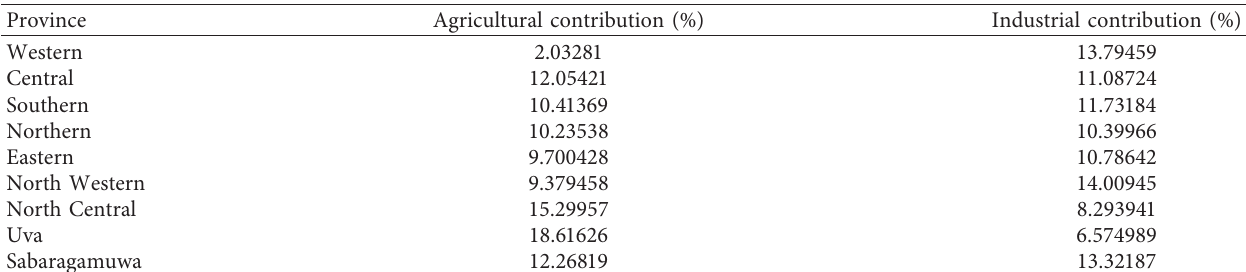
Table 1: Agriculture and industrial contribution from each province to the economy of Sri Lanka (source: Economic Statistics of Sri Lanka, Department of Census and Statistics, Sri